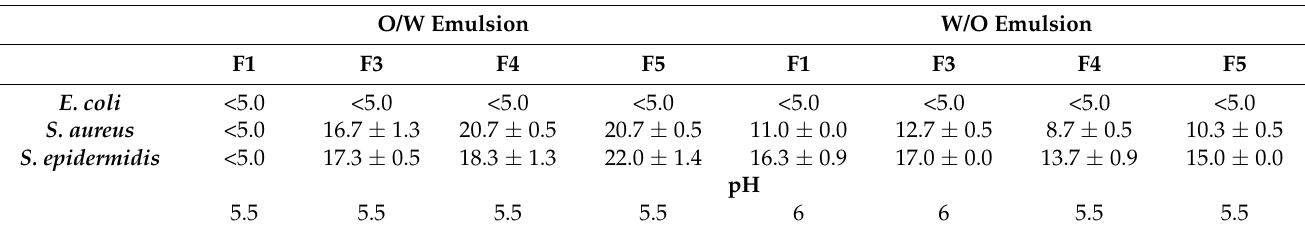
Table 3. Results of the antibacterial assay inhibition halo diameter values for the O/W and W/O formulations and pH value. Antibacterial Assay Inhibition Halos (mm) of the Formulations O/W Emulsion W/O